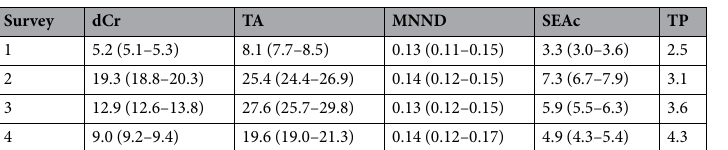
Table 2. Community-wide metrics calculated using SIBER analyses based on the invertebrate taxa δ 13 C and trophic position values. Abbreviations: dCr – carbon range, TA – total convex hull area, MNND – mean nearest neighbour distance values, SEAc – standard ellipse areas, TP – trophic position (measure of trophic chain